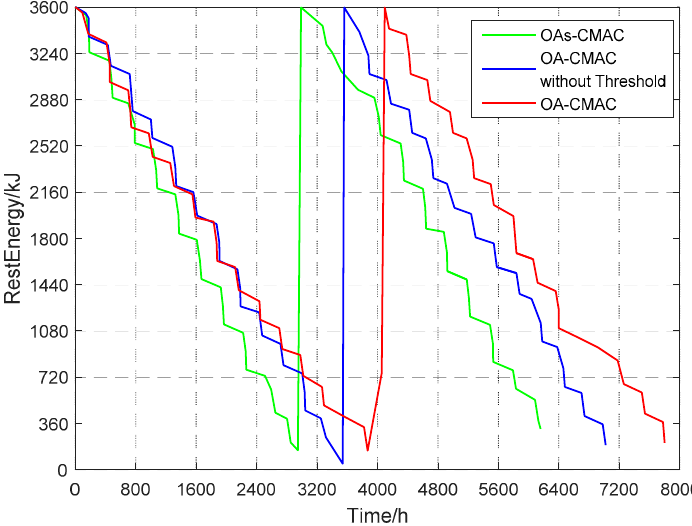
Figure 9. Optical-acoustic energy-efficient competitive media access control (OA-CMAC) protocol node energy consumption simulation.